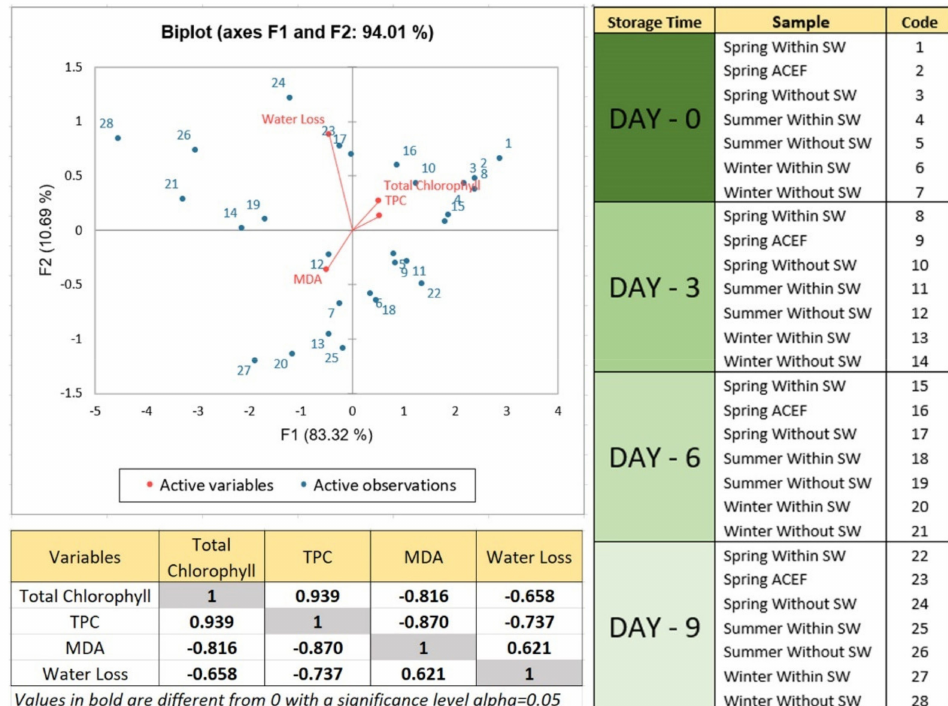
Figure 8. Principal component analysis (PCA) on physicochemical quality of seagrape during post-harvest